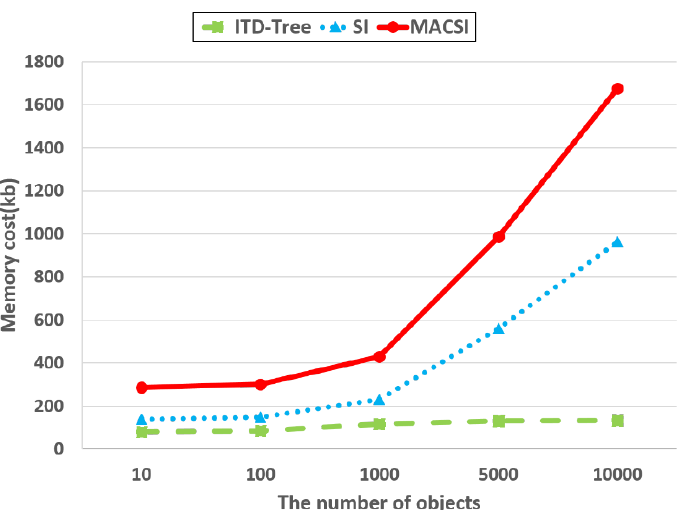
Figure 30. The effect of cell number on memory costs.